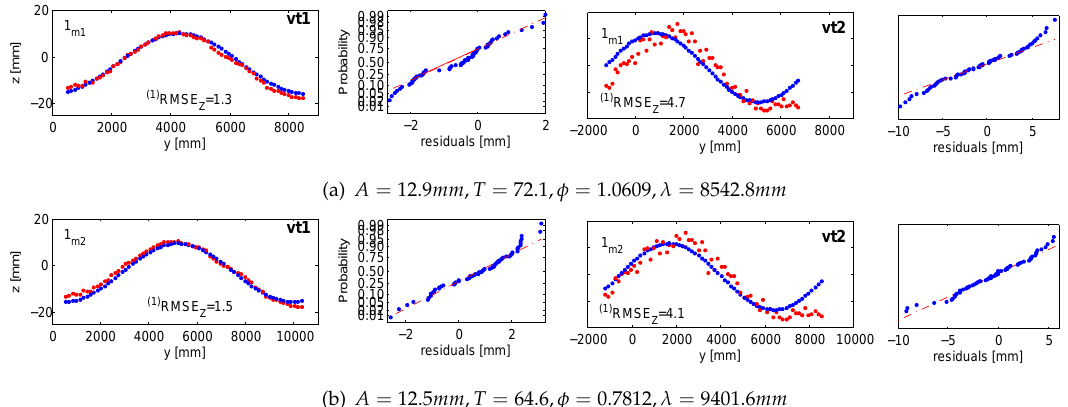
Figure 13. Accuracy 1 validation results in the first measurement series for m 1 in ( a ) and m 2 in ( b ), compared against the response of vt 1 and vt 2. Ground truth in red; fitted wave model in blue. The normal probability plots are in even